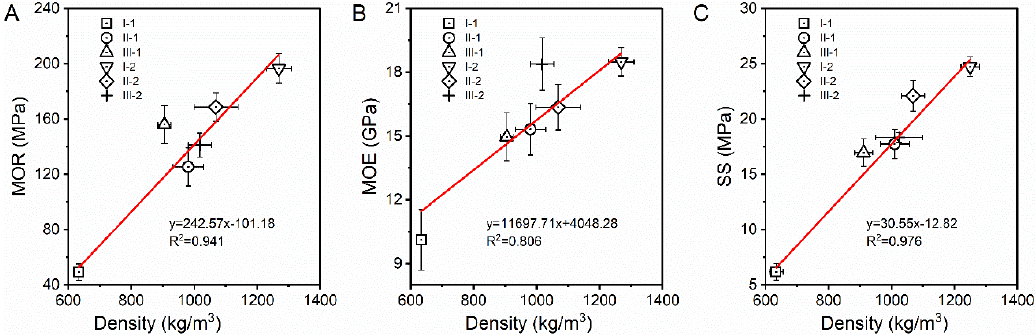
Figure 8. Mechanical properties of the LC samples: ( A ) MOR, ( B ) MOE, and ( C ) SS.